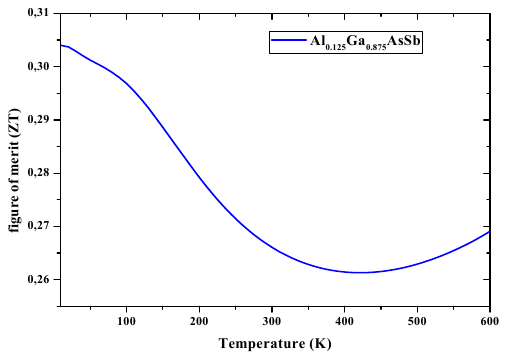
Figure 6. Figure of merit (ZT) of AlGaAsSb nanostructured material within the 0 − 600 ◦ K range.